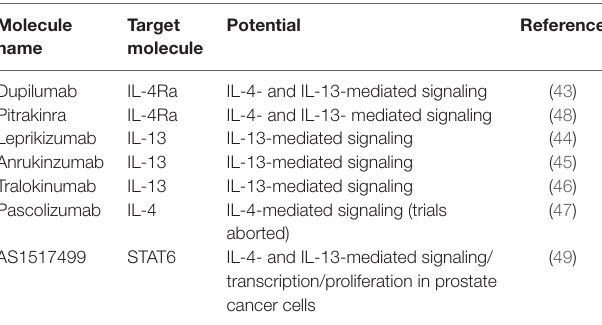
TABLe 1 | Examples of various steps interleukin (IL)-4/IL-13 signaling could potentially be